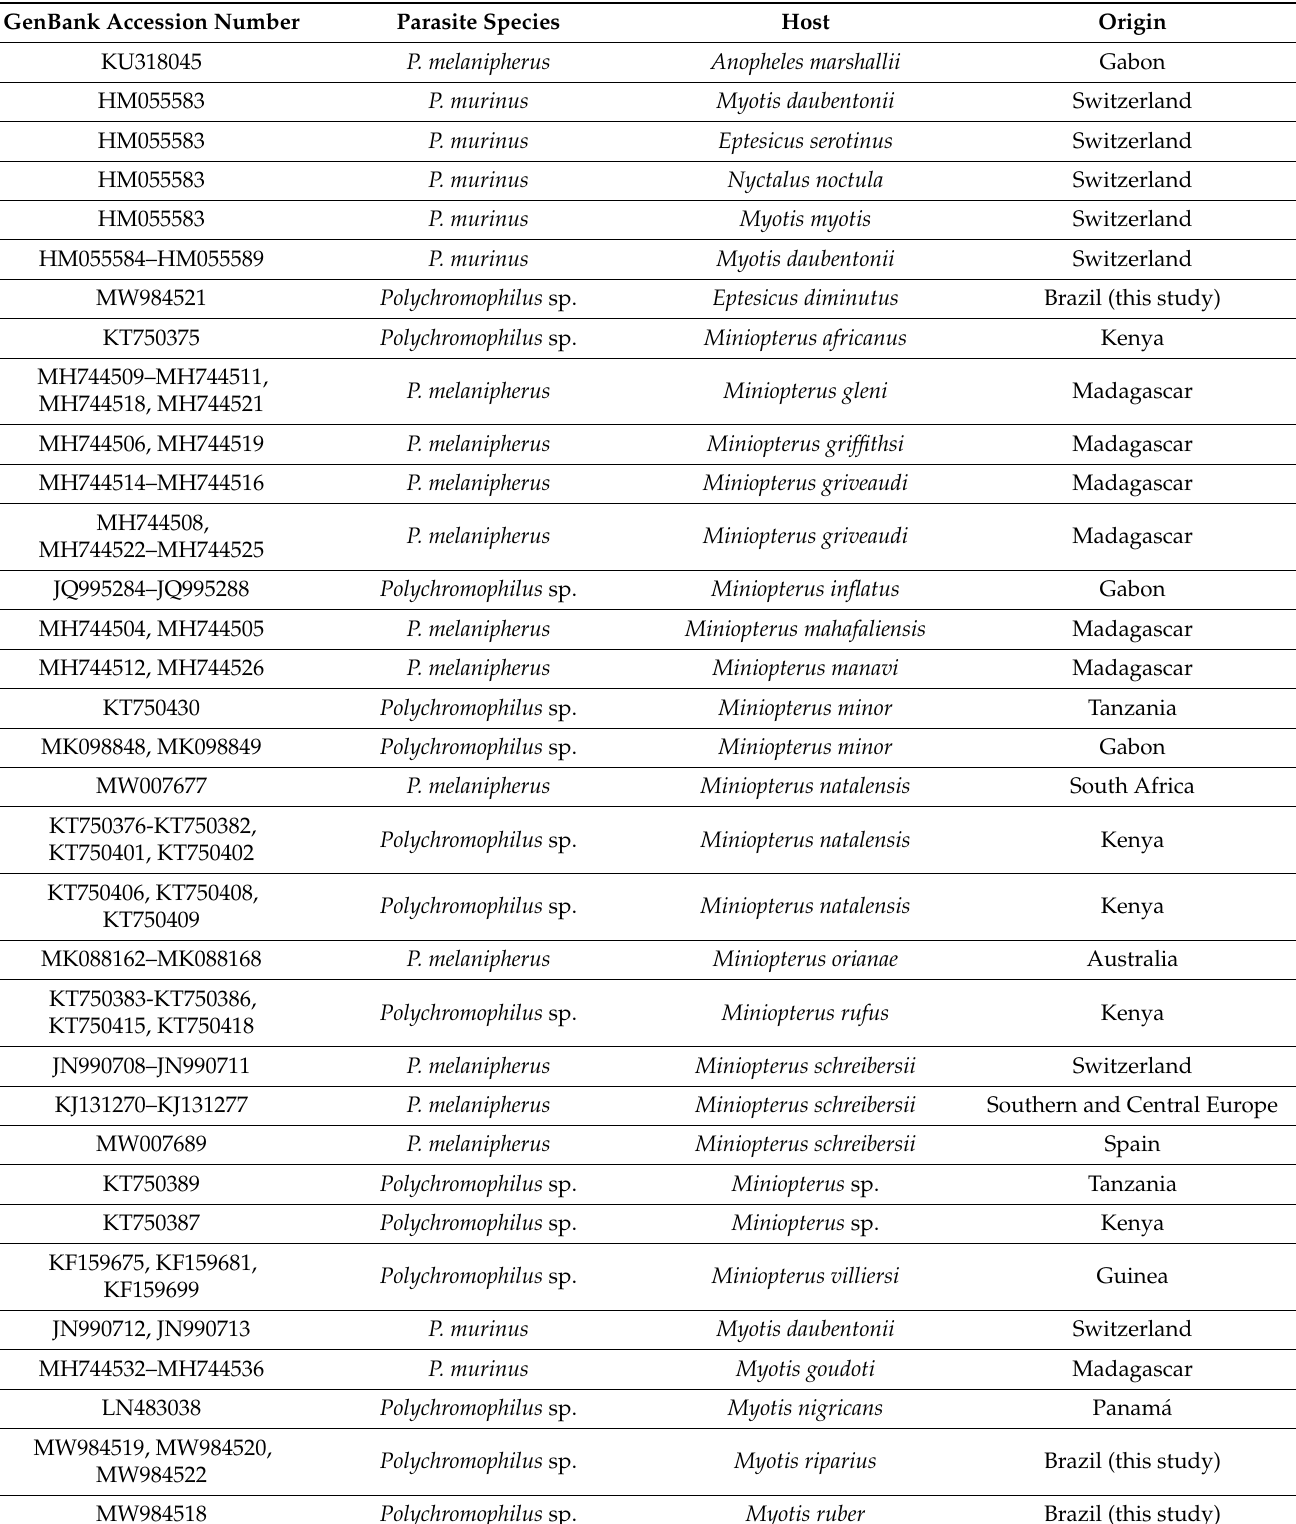
Table A2. Genbank ® accession numbers of Polychromophilus mitochondrial cytochrome b gene ( cytb ) sequences used as a reference for phylogenetic analyses and sequences found in this